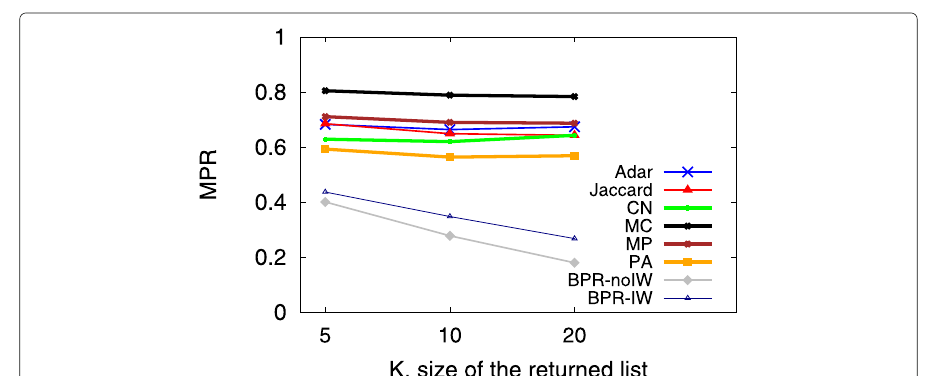
Fig. 6 MPR with different K on